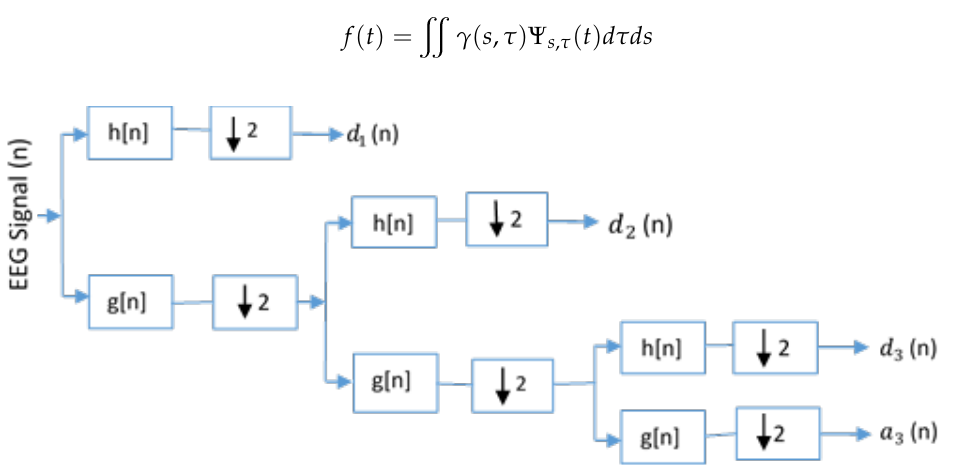
Figure 1. Decomposition of signals using DWT: Multiresolution analysis.